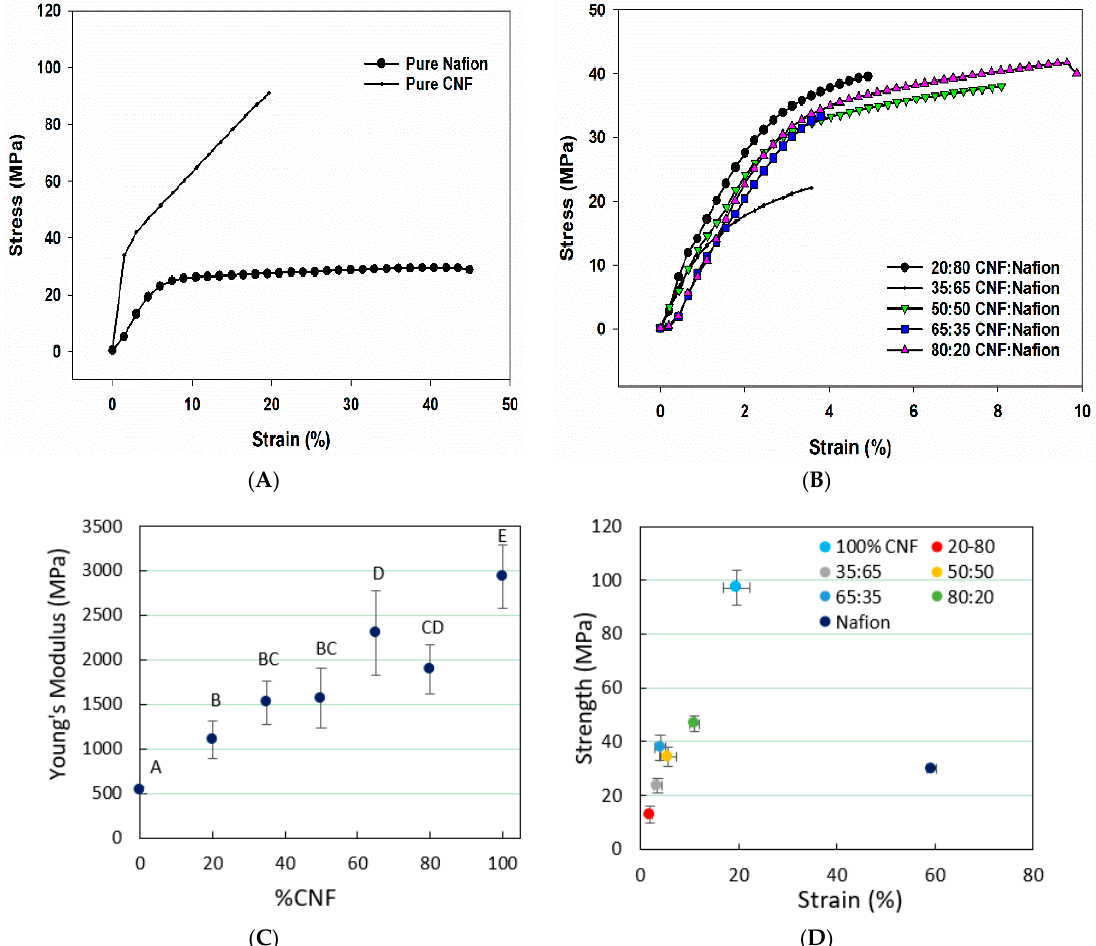
Figure 3. Graphs showing the typical stress-strain curves of pure materials and the hybrids thereof ( A and B , respectively), tensile data obtained from CNF-Nafion® membranes with different CNF contents: ( C ) Young’s modulus and ( D ) tensile strength-strain relationship. Data points with common letters are not statistically significant at 95% confidence level, as determined by statistical analysis. In figure (d), all the ratios follow the same CNF/Nafion® order.